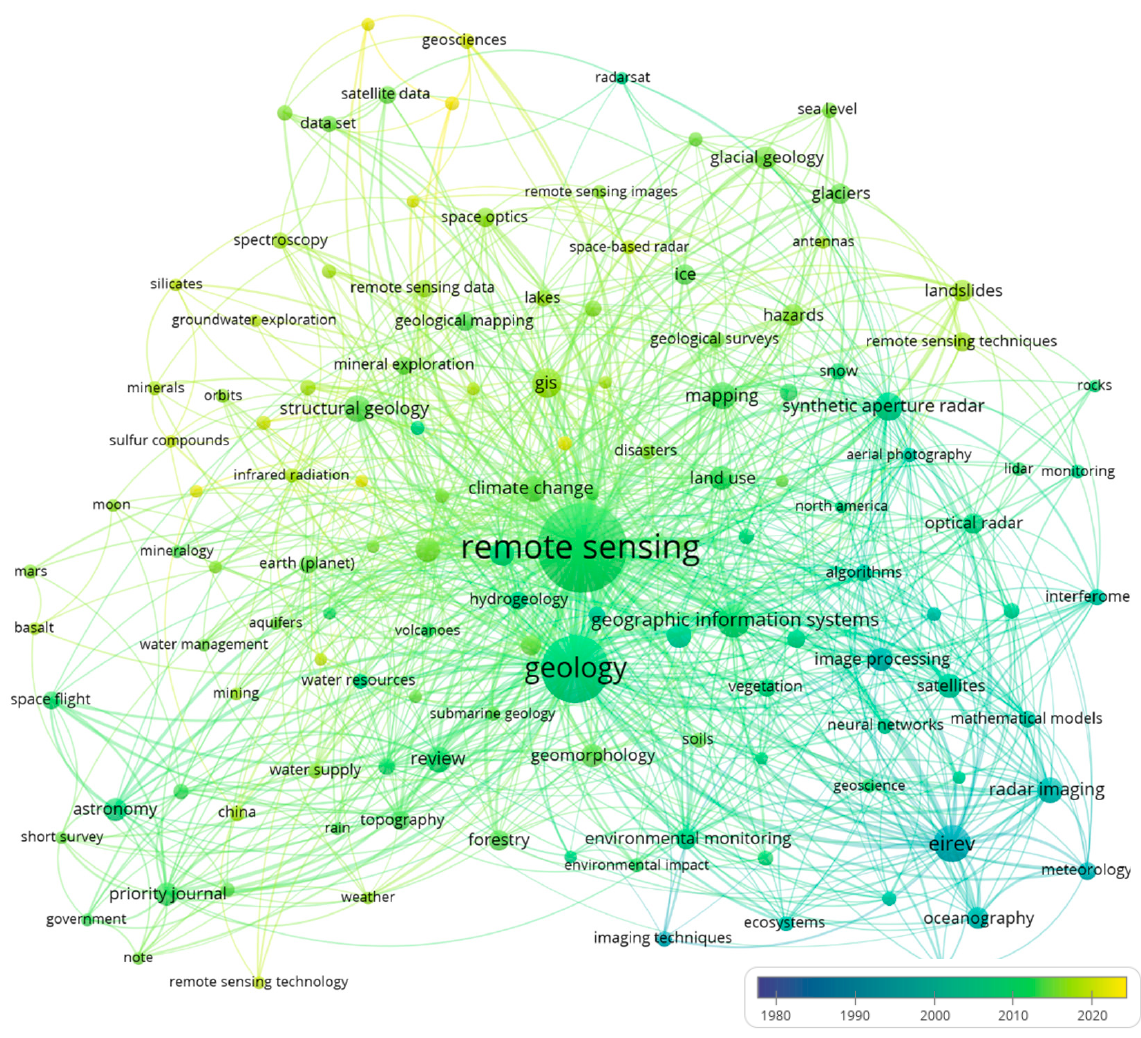
Figure 4. Keywords found in Scopus while looking for works with the keywords “Remote sensing” and “Geology”. Graphic made with VOSviewer.